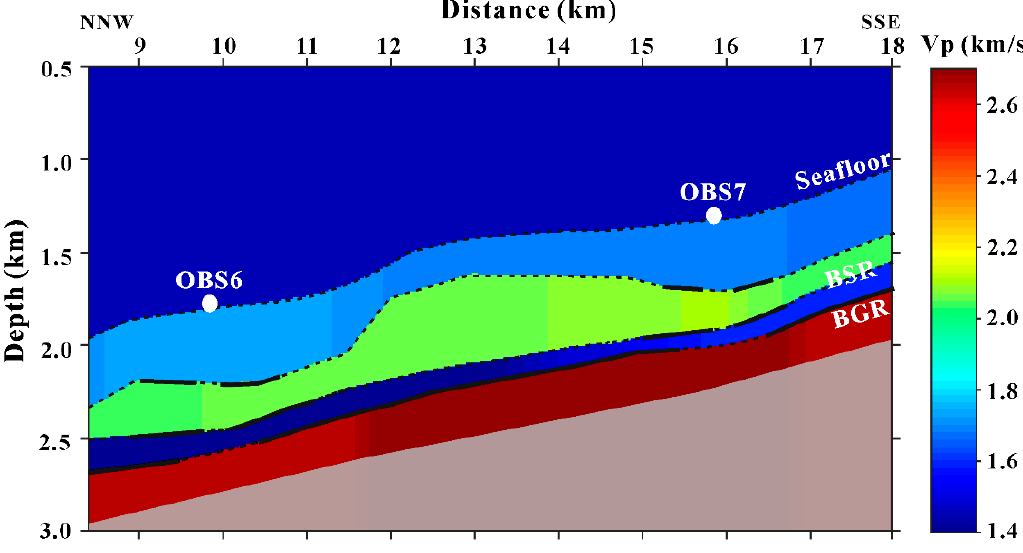
Figure 6. P-wave velocity model determined by inversion of MCS and OBS data. Solid boundary lines indicate the P-wave ray coverage for the different layer interfaces. The grey shading indicates the area with no ray coverage.